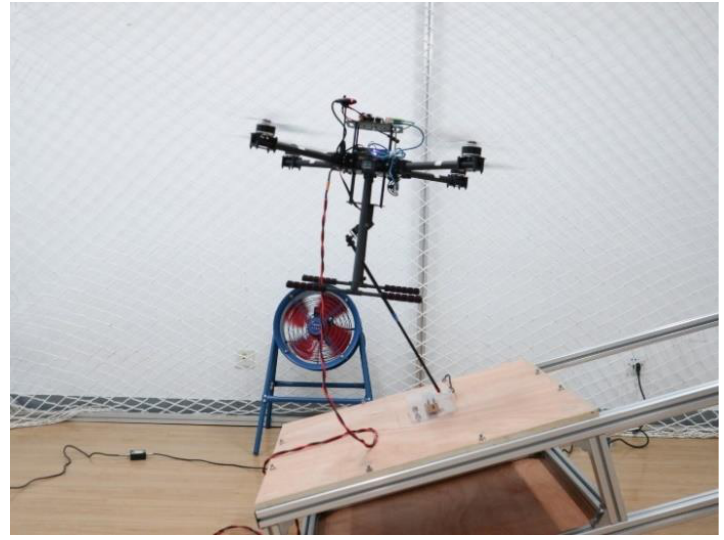
Figure 19. The contact force formation experiment of the UAM system.